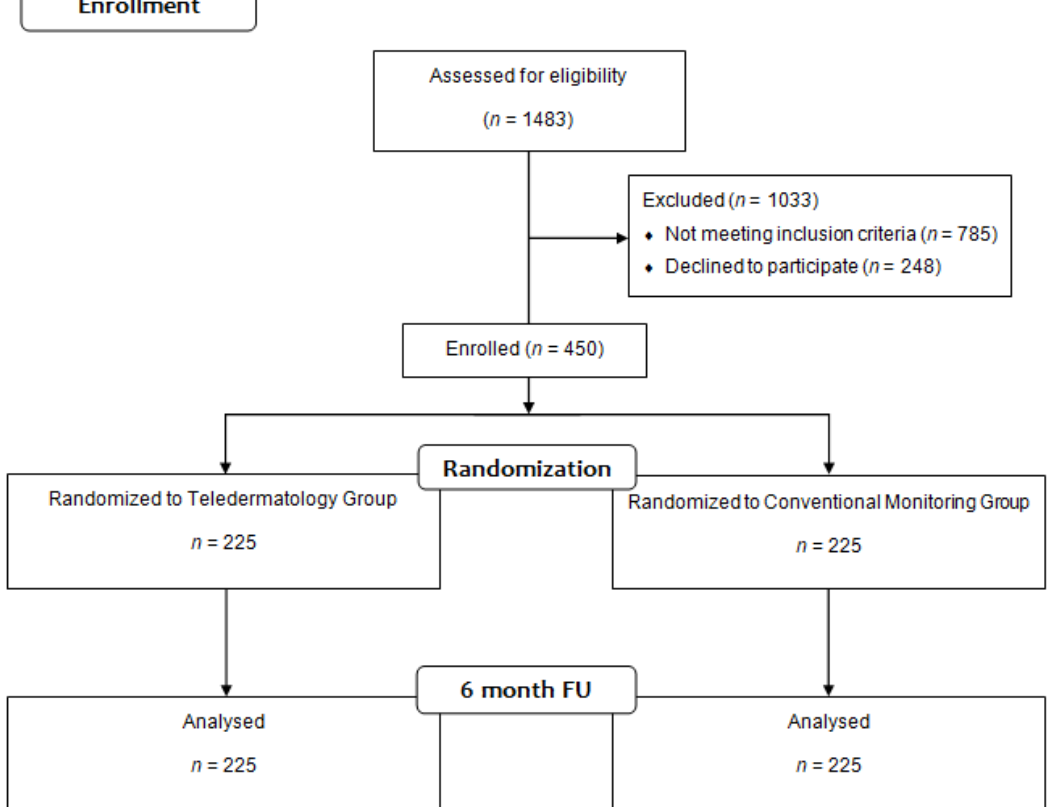
Figure 1. CONSORT 2010 Flow Diagram participants.